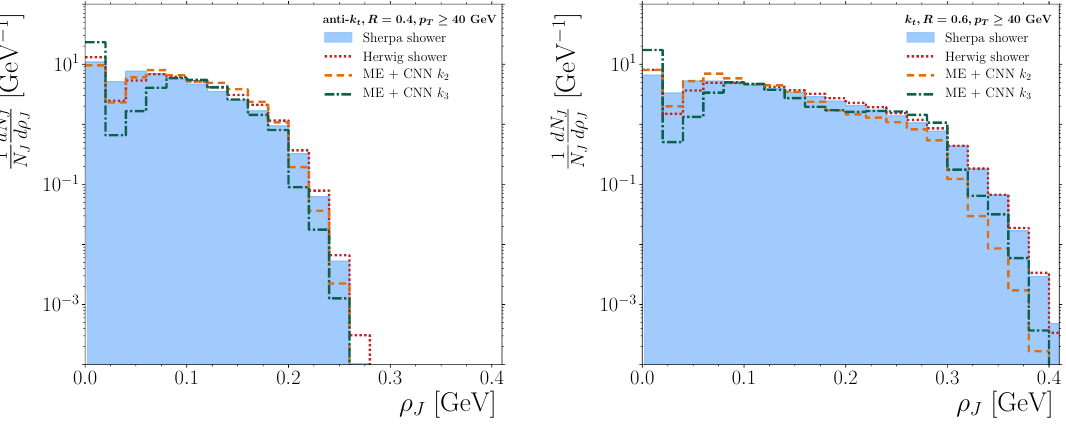
Figure 7 . Jet width distributions using the anti- k t R=0.4 jet algorithm (left) and the k t R=0.6 algorithm